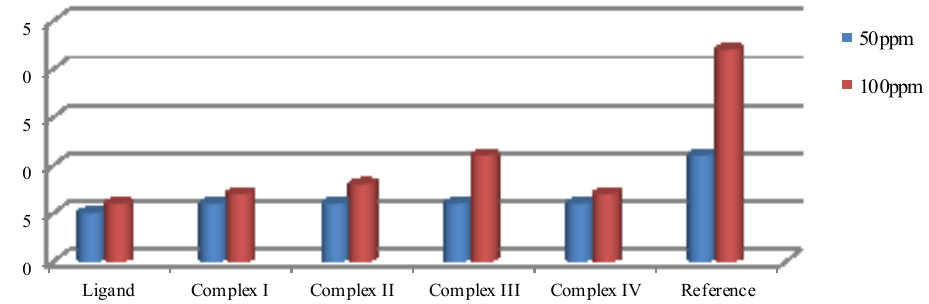
Figure 5a. Effect of different concentration of ligand and complexes with Escherichia coli.